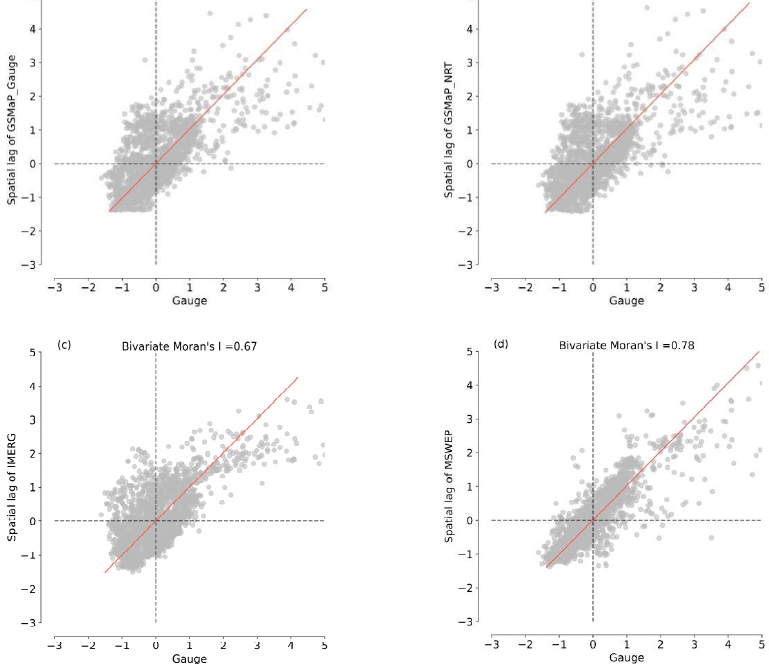
Figure 6. The global BMI scatter plot of CDD between the gauge observations and the four SPPs: ( a ) GSMaP_Gauge, ( b ) GSMaP_NRT, ( c ) IMERG, and ( d ) MSWEP.